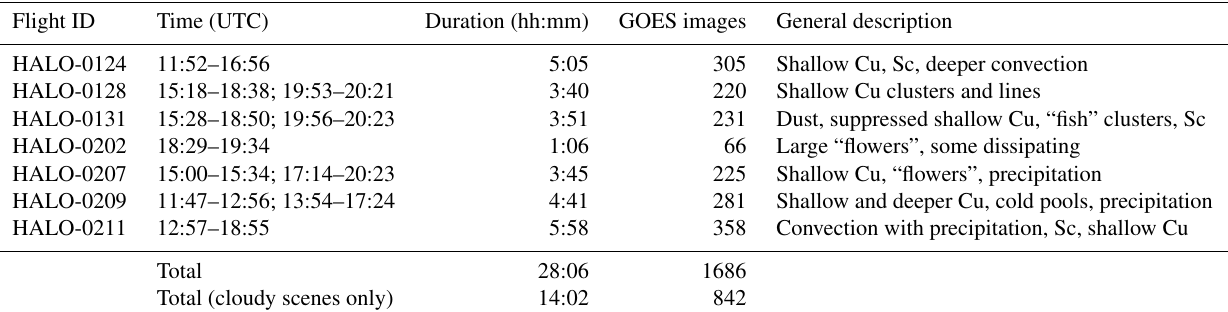
Table 2. The flights from EUREC 4 A that are used in this analysis are given here with their respective flight IDs (HALO-mmdd) along with the times when HALO was in the circling flight pattern and GOES-16 data were available. The amounts of time and number of GOES images are for cloudy and cloud-free sky, but the total amount of time and number of GOES images for cloudy sky only are given as well. The general descriptions of the flights come from notes in the flight